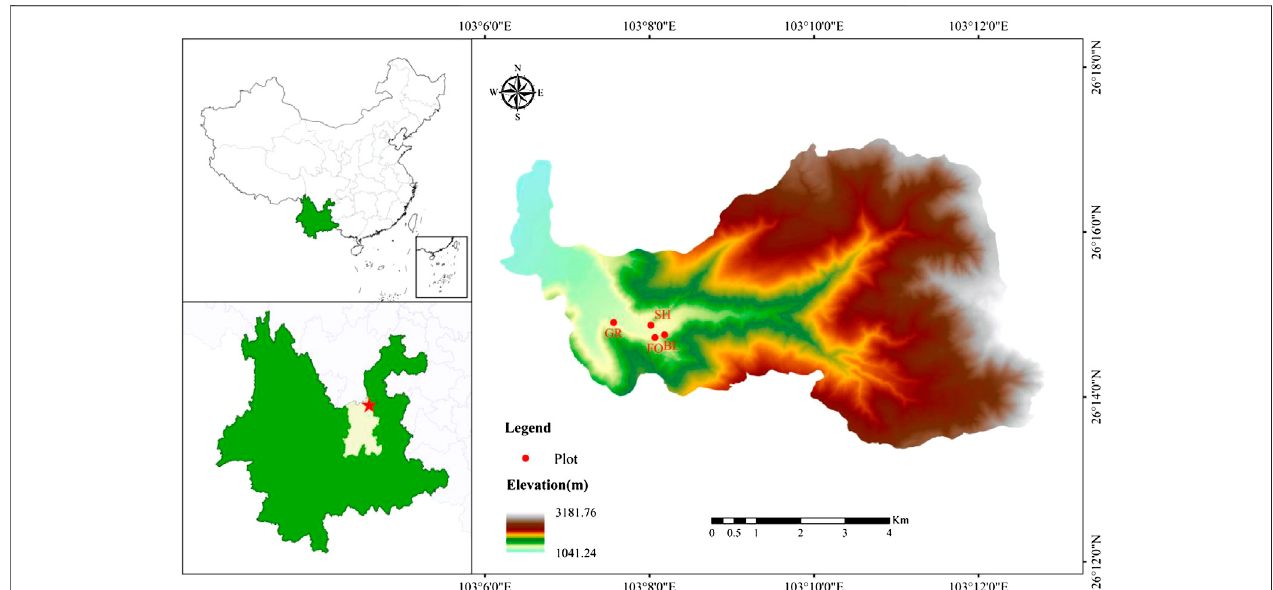
FIGURE 1 | Geographic location of the Jiangjiagou gully and four vegetation plots. BL: Bare land; GR: Grassland; SH: Shrub; FO: Forest.